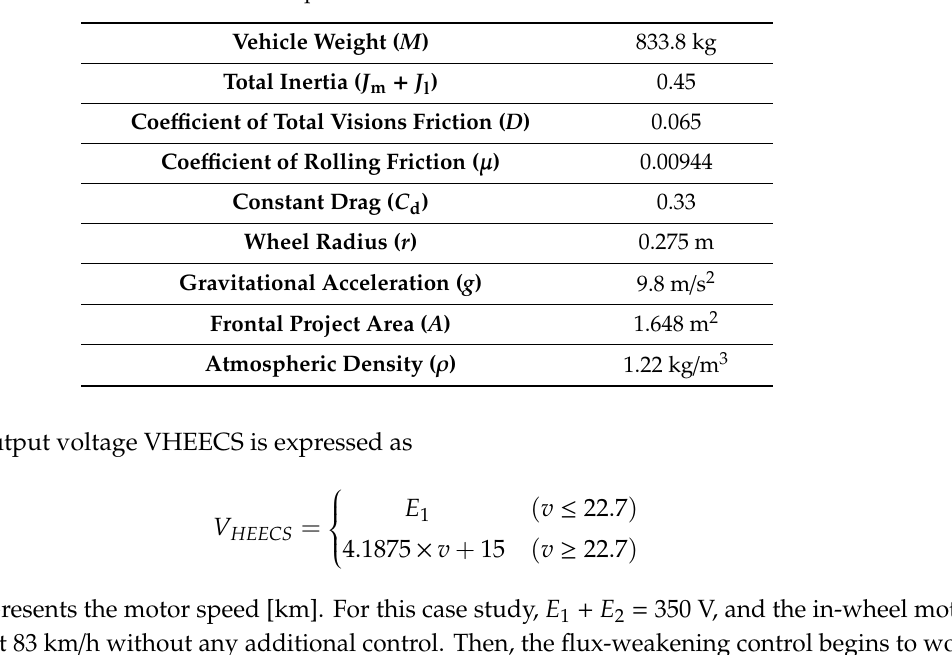
Table 1. Specifications of the KANA vehicle.